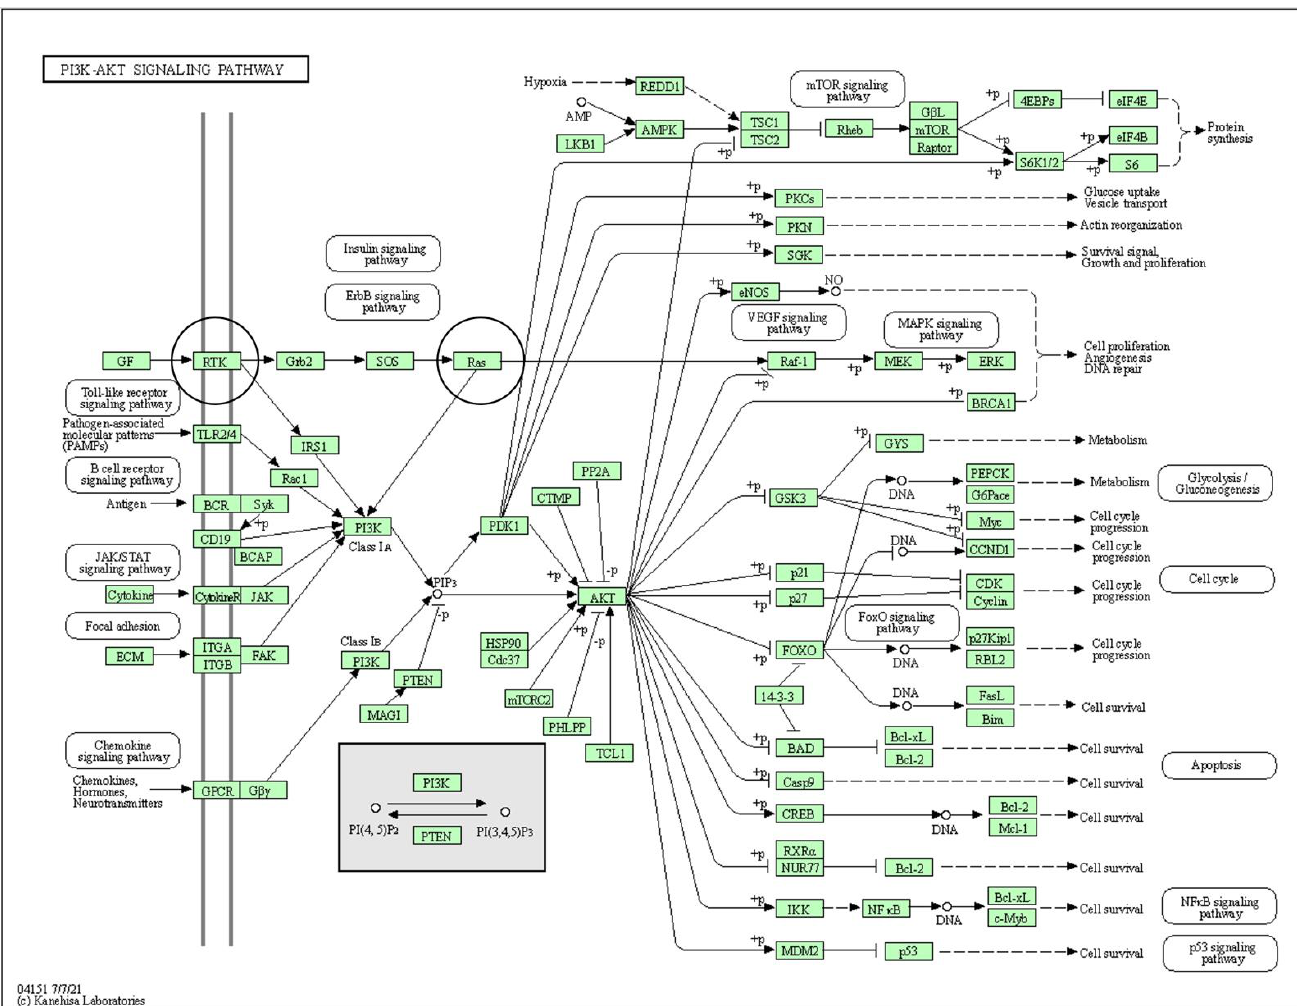
Figure 3. References [29,30,38]. KEGG Pathway – Phosphatidylinositol-3-kinase protein kinase B (PI3K-akt; KEGG entry ID: hsa04151). The classic PI3K-akt pathway is involved in conjunctival melanoma (CM). The black circles identify proteins with known mutations in CM, c-KIT (map id: RTK), and NRAS (map id: Ras). More information about any protein seen in the pathway (i.e. abbreviation definition, gene function, protein sequence, etc.) can be accessed through the interactive Kyoto Encyclopedia of Genes and Genomes (KEGG) pathway (available at: https://www.genome.jp/pathway/hsa04010 (accessed on 15 May 2021)).